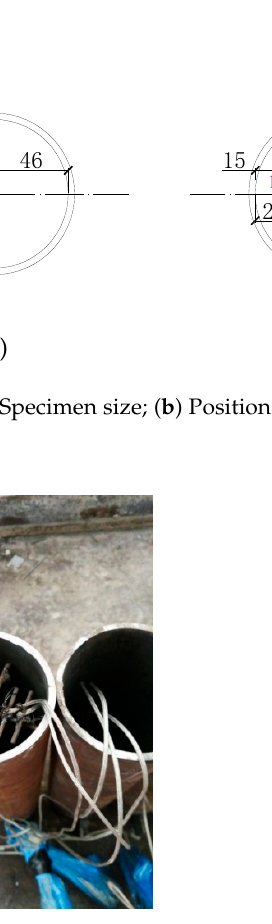
Figure 5. Steel positioning skeleton.